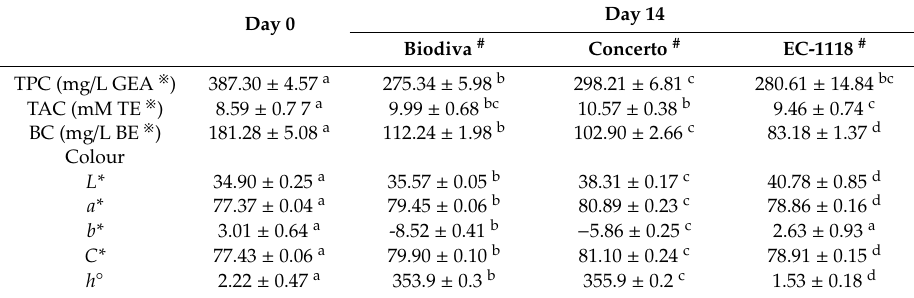
Table 3. Total phenolic content (TPC), total antioxidant capacity (TAC), betacyanin content (BC) and CIE Lab colour parameters of red dragon fruit juice and wines fermented with Saccharomyces and non- Saccharomyces yeast strains.